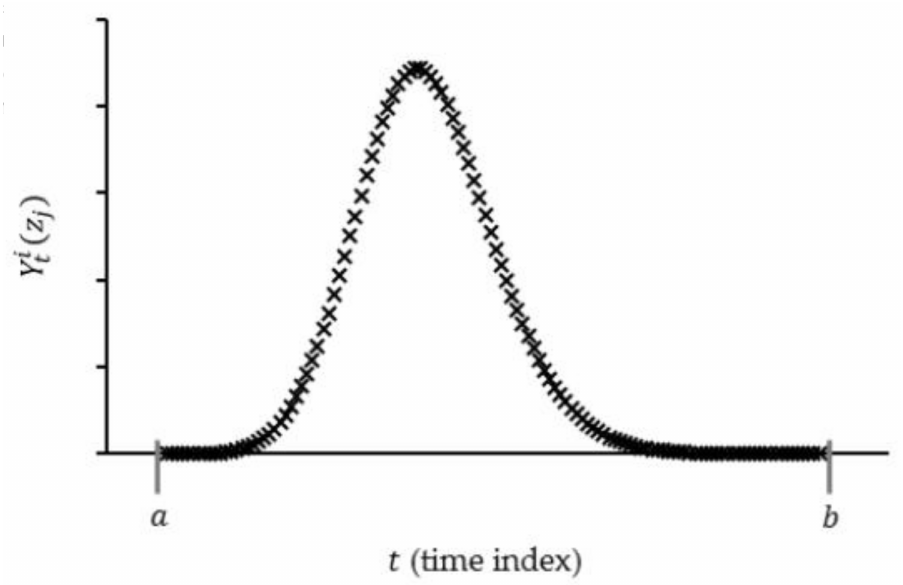
(cid:16) (cid:17) z j over t